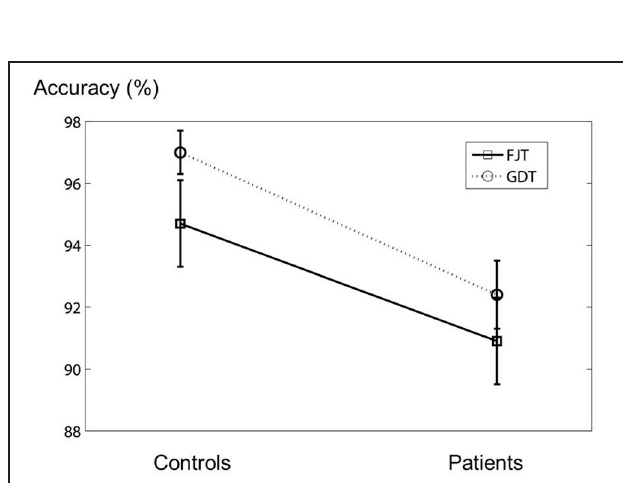
FIGURE 3 | The figure shows the error bar (mean ± SD ) of the accuracy in the fMRI experiment. The vertical axis represents the accuracy of the experiment.